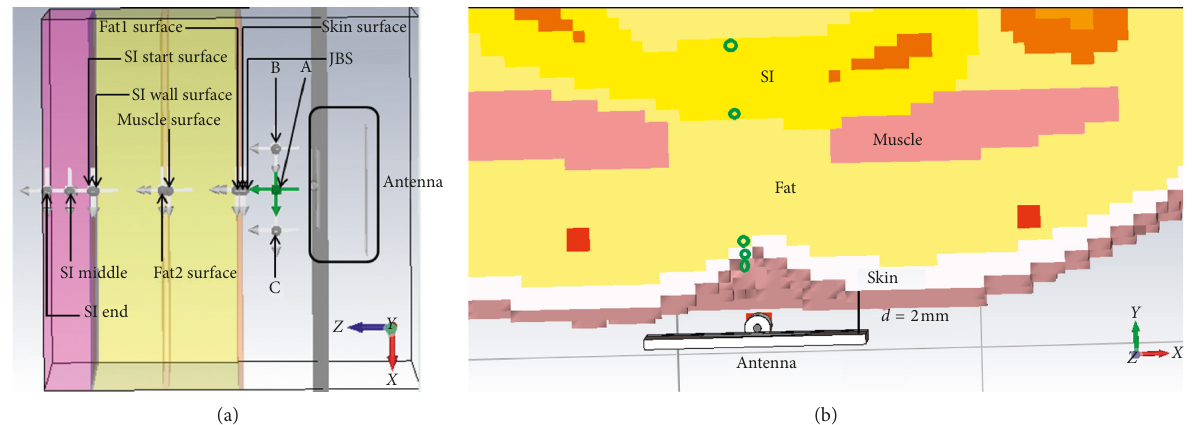
Figure 24: Position of the E-field probes with respect to the top view of the (a) multilayer model and (b) voxel model using reflector-backed